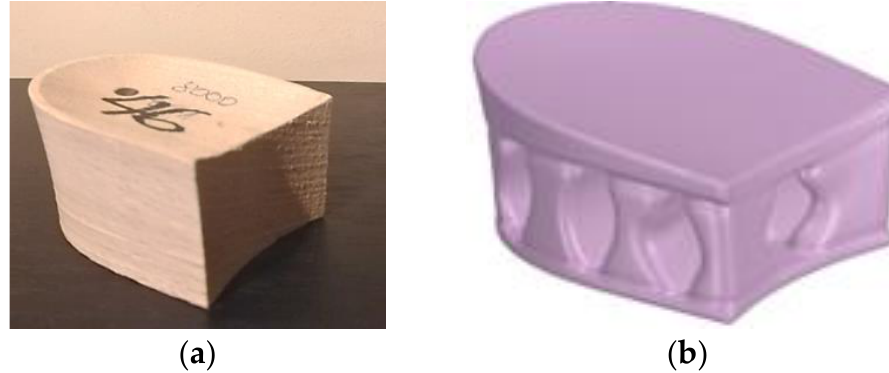
Figure 1. Orthopedic heel: ( a ) standard wooden heel; ( b ) designed heel model.